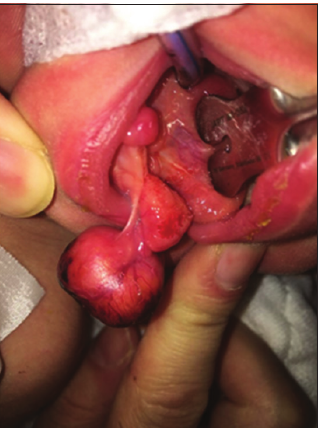
Figure 1: Two prolapsed solid lesions were observed originating from the gingiva and there were ulcerous areas on the surface of the masses